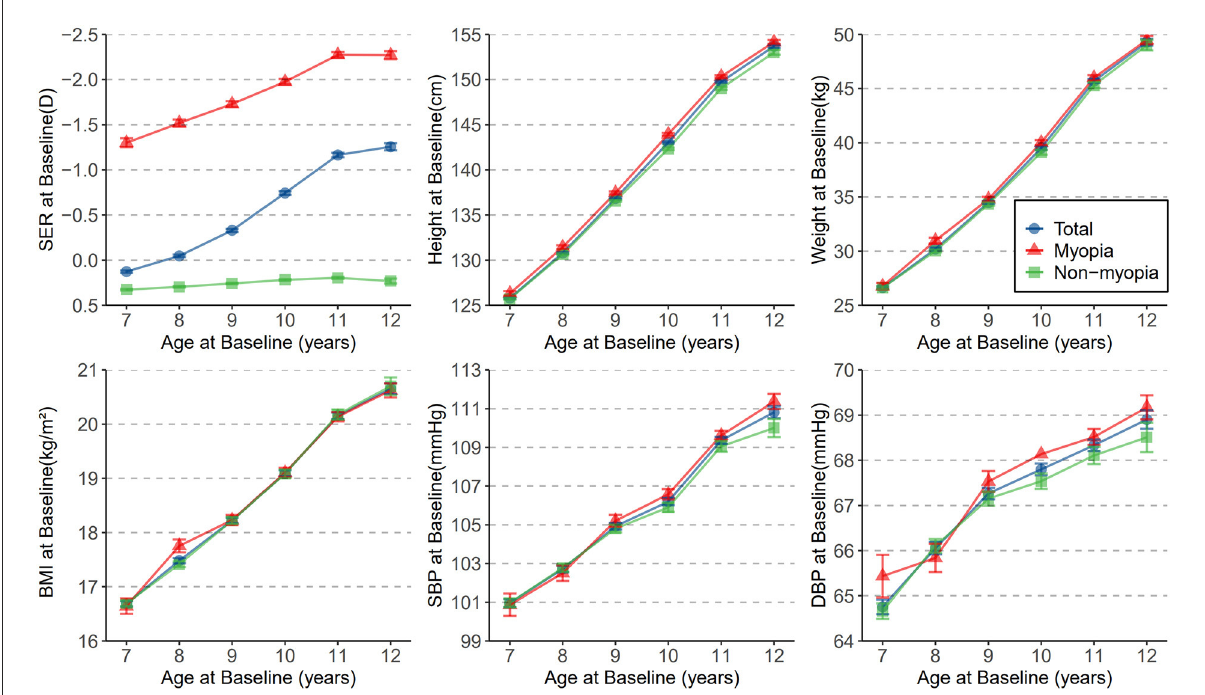
FIGURE1 The distribution of mean SER, height, weight, BMI, SBP, and DBP with age at baseline. Dots represents means and whiskers indicate SEM. SER, spherical equivalent refraction; BMI, body mass index; SBP, systolic blood pressure; DBP, diastolic blood pressure.